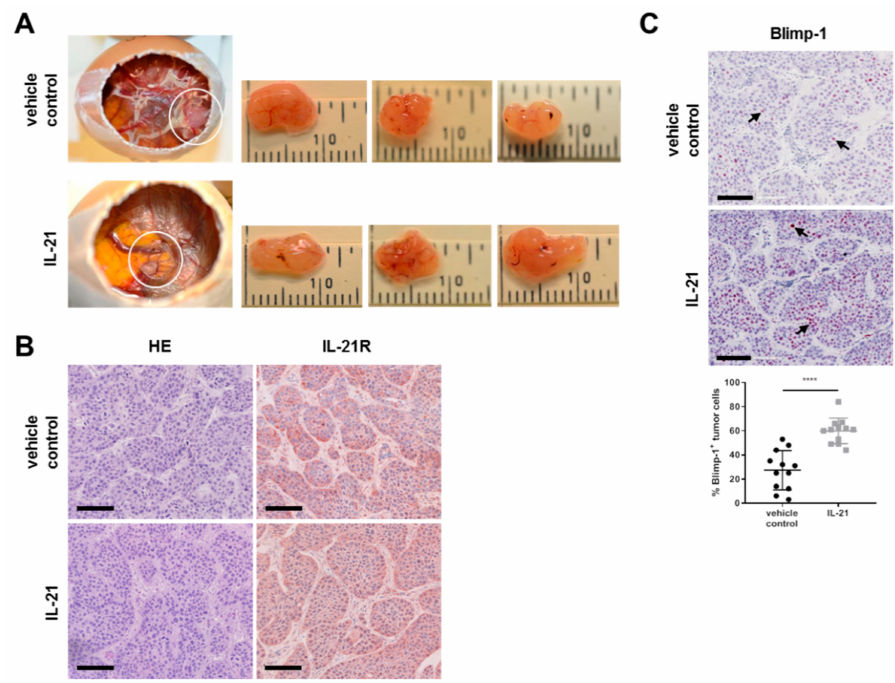
Figure 6. Treatment of avian xenografts with IL-21 upregulates Blimp-1 expression. ( A ) The three-dimensional growth of BxPC-3 cells transplanted on the CAM of fertilized chicken eggs and resected tumors (three replicates) from vehicle control and IL-21 were photographed at day 17 of embryonic development. Upper row for vehicle control; lower row for IL-21-treated (150 ng / mL) tumors. ( B ) HE and IL-21R (brown) IHC staining of vehicle control and IL-21-treated (150 ng / mL) resected xenograft tumors. ( C ) Comparison and quantification of Blimp-1 (nuclei: red) expression of vehicle control and IL-21-treated (150 ng / mL) xenograft tumors. **** P < 0.0001. Unpaired t